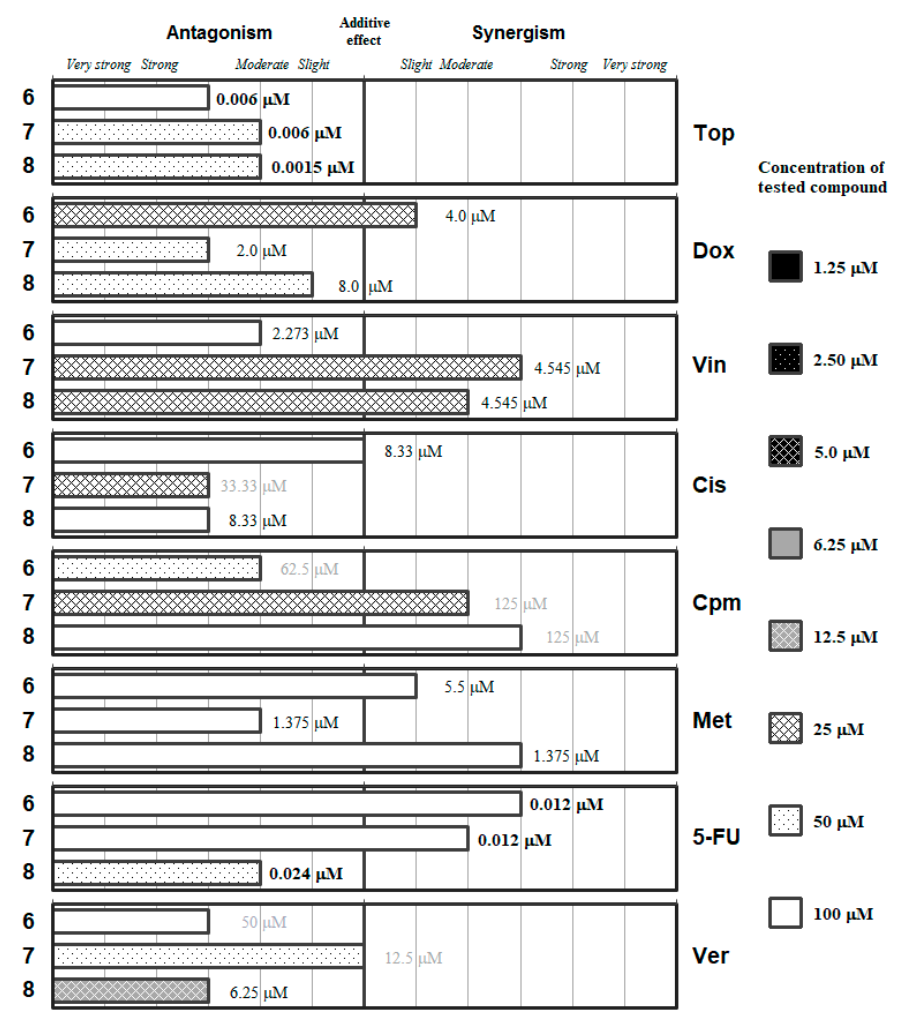
Figure 4. Interactions of the carbamoyl selenoester ( 6 ) and of the R ‐ ylcarbonyl selenoesters ( 7 and 8 ) with a panel of anticancer drugs ( Top , Dox , Vin , Cis , Cpm , Met and 5 ‐ FU ) or an efflux pump inhibitor ( Ver ). Concentration of the tested compound is given according the legend; concentration of the anticancer drug is given in numbers inside the graph (in bold: below 0.1 µ M, in italics between 0.1 µ M anticancer drug is given in numbers inside the graph (in bold: below 0.1 μ M, in italics between 0.1 and 1 µ M, and in grey above 10 µ μ M and 1 μ M, and in grey above 10 μ M).